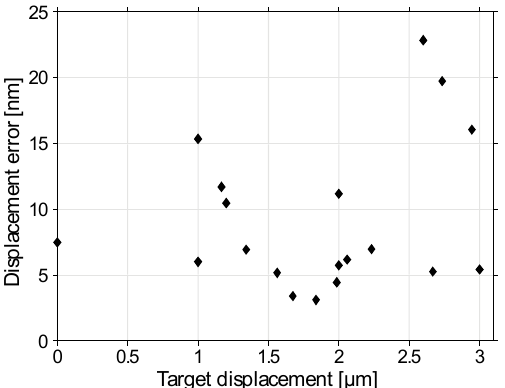
Figure 12. Displacement error of the beam focus versus target displacement √𝑋 (cid:2870) + 𝑌 (cid:2870) + 𝑍 (cid:2870) . The average measured displacement error was <0.6% of the displacement.